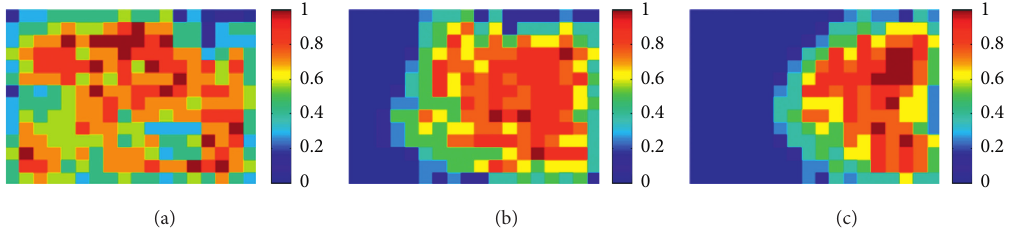
Figure 19: Proportion of state group I under different perception radius when N � 300. (a) λ � 0 . 6. (c) λ emotion